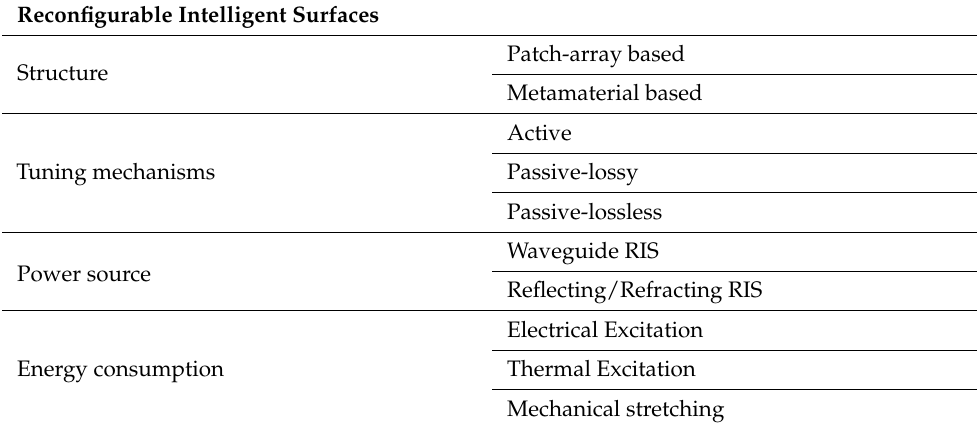
Table 9. Types of metasurfaces being used for the design of 6G wireless